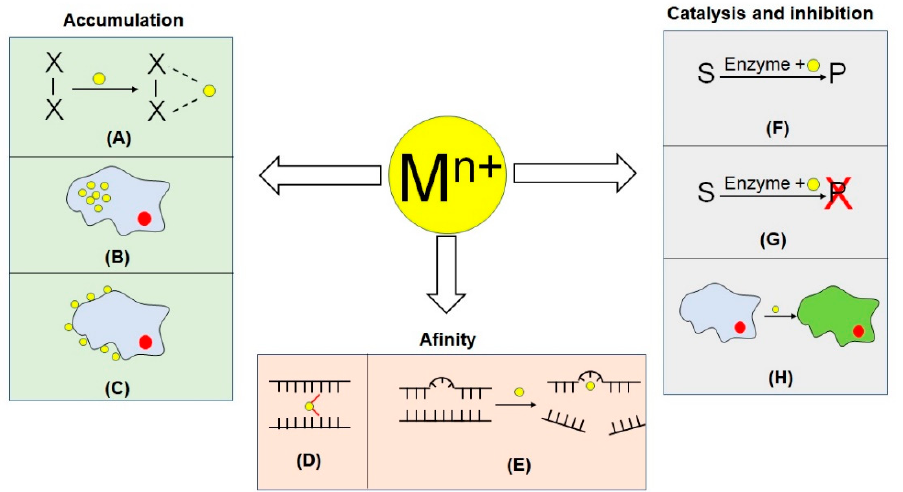
Figure 3. Scheme of the main mechanisms of biosensors for metal ions